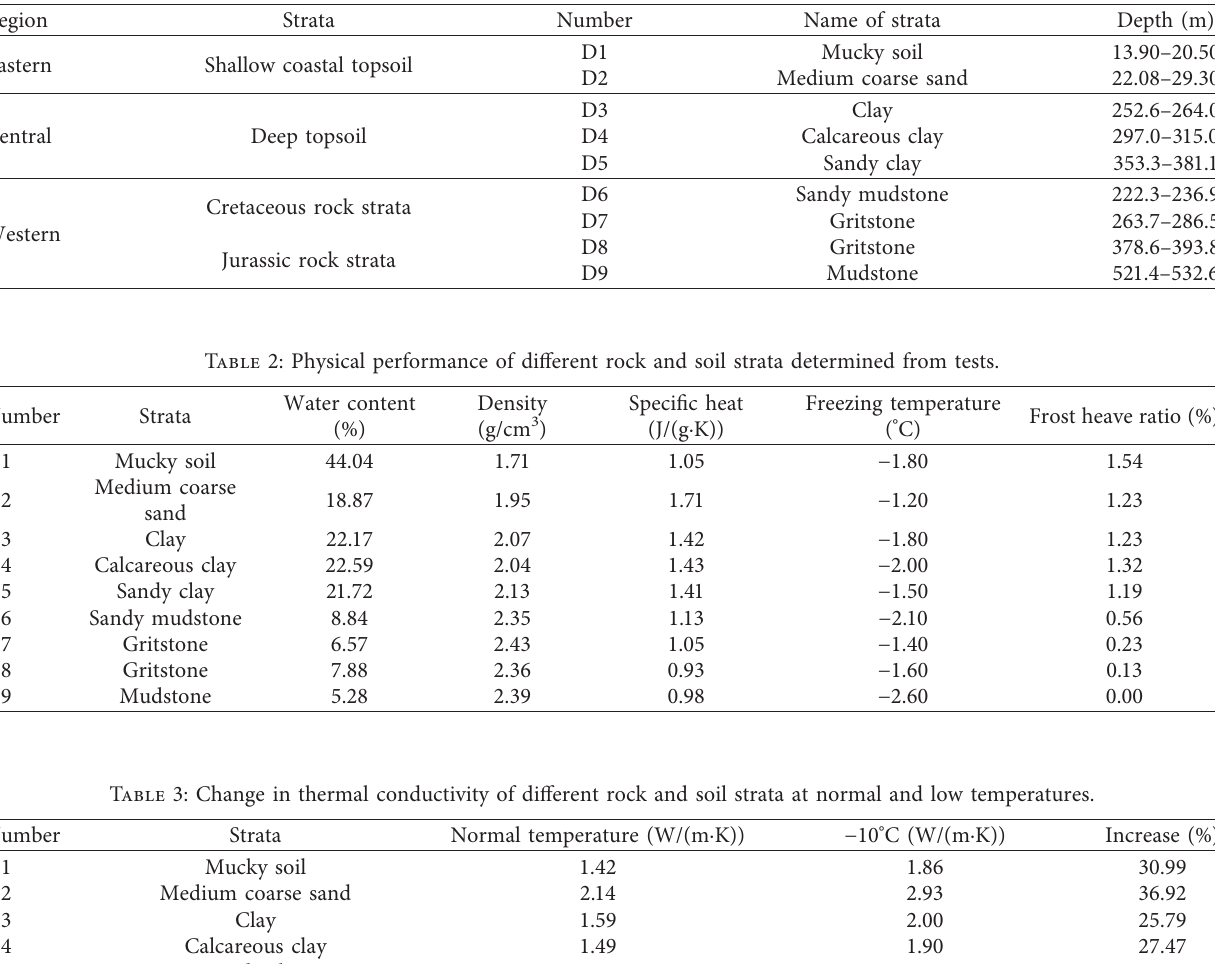
Table 1: Basic condition of rock strata